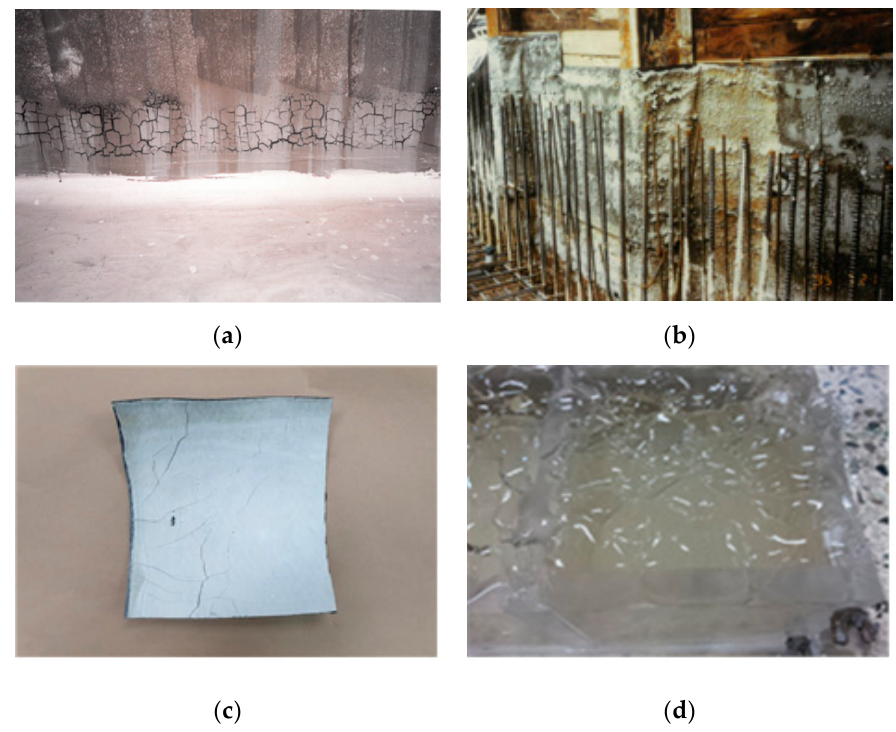
Figure 1. The problems of existing waterproofing materials with water expansion properties: ( a ) Drying shrinkage of a bentonite sheet.; ( b ) Surface condensation during construction.; ( c ) Drying shrinkage of an acrylate sheet.; ( d ) Gelation of acrylate.